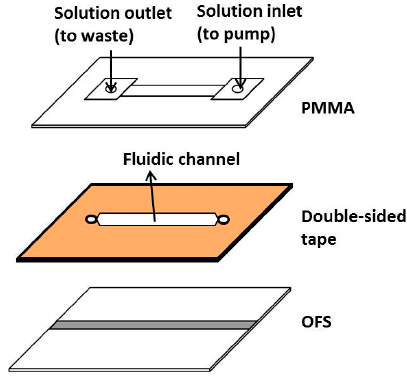
Figure 3. The design of the microfluidic chip composed of a polymethylmethacrylate (PMMA) substrate, a double-sided tape, and a D-type optical fiber sensor (OFS) embedded inside a glass substrate.